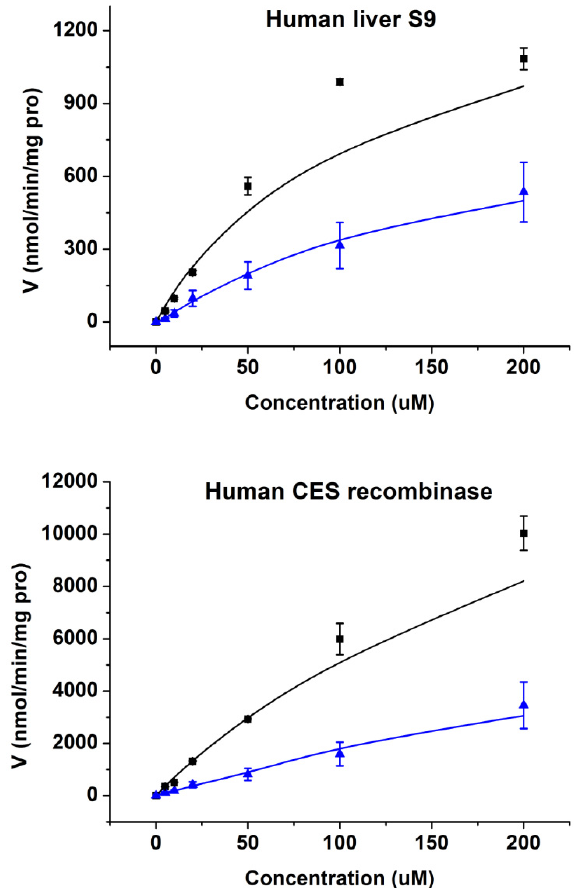
Figure 5. The enzyme kinetics of Cbz-dFdC in human liver S9 and CES1 recombinase. Black square and black line represent observed and simulated values of Cbz-dFdC disappearance in incubation. Blue triangle and blue line represent observed and simulated values of dFdC appearance in incubation.